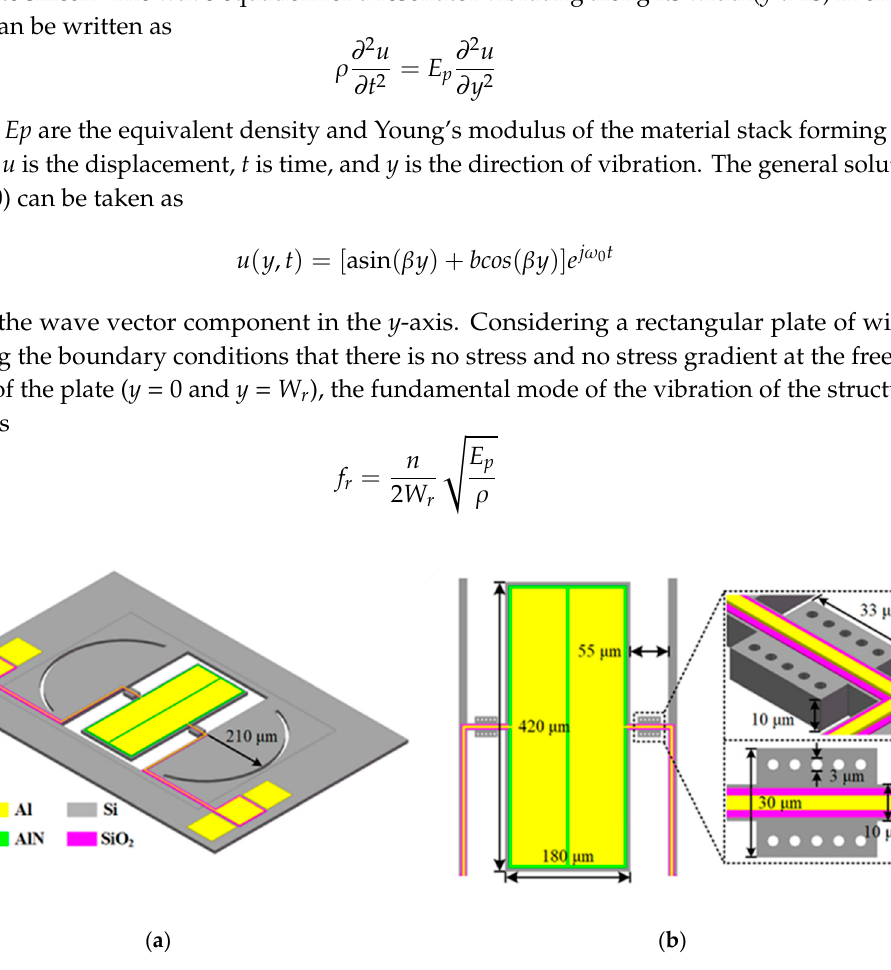
Figure 4. Illustration of the proposed aluminum nitride-on-silicon (AlN-on-Si) microelectromechanical (MEMS) resonators. ( a ) 3D schematic view of the proposed configuration that integrates PnC-reflector composite structure; ( b ) The top view and the enlarged view of the PnC structure at the tether.